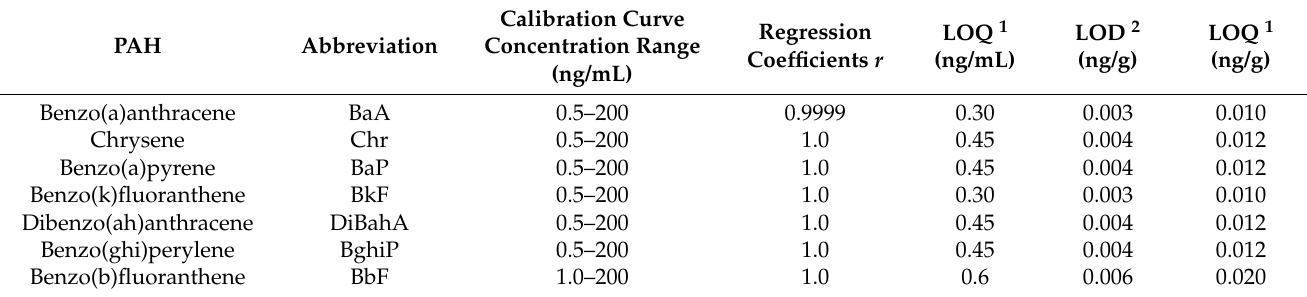
Table 2. Data from PAHs determination by HPLC-FLD